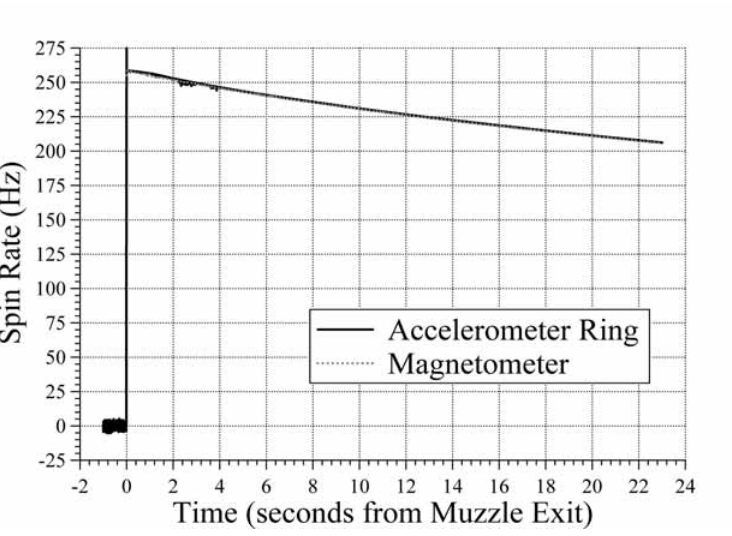
Fig. 11. Projectile spin rate comparison vs.